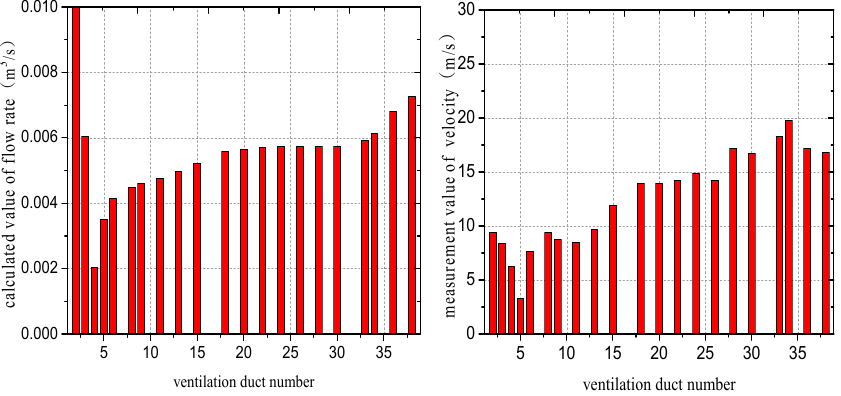
Figure 8. Comparison of calculated and measured values of fluid flow rate in the ventilation duct.